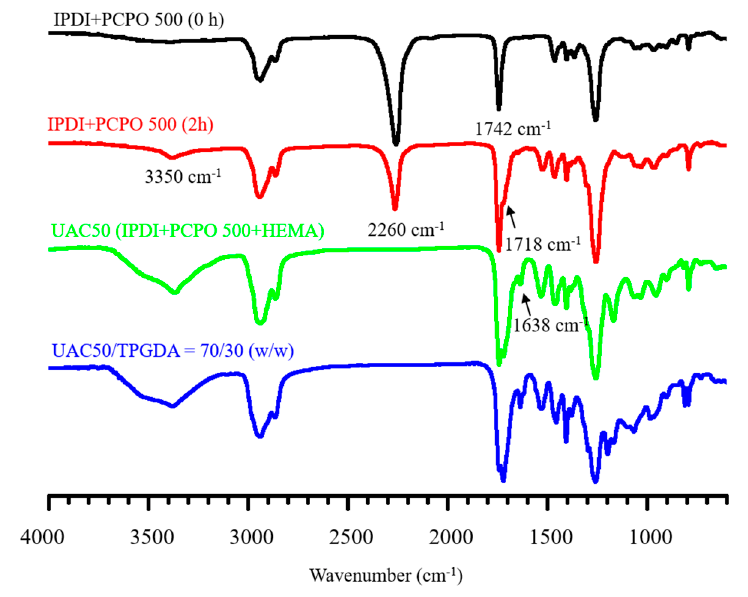
Figure 5. FTIR spectra of UAC50 and UAC50/TPGDA.